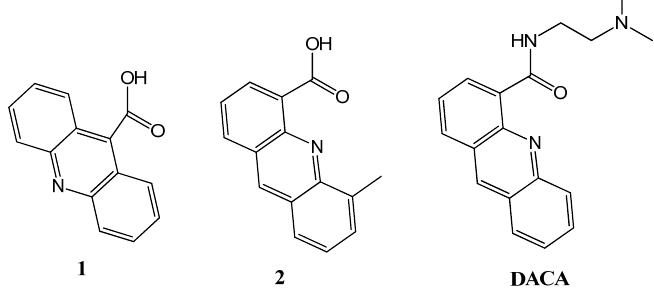
Figure 1. Chemical structures of N -[2-(dimethylamino)ethyl]acridine-4-carboxamide